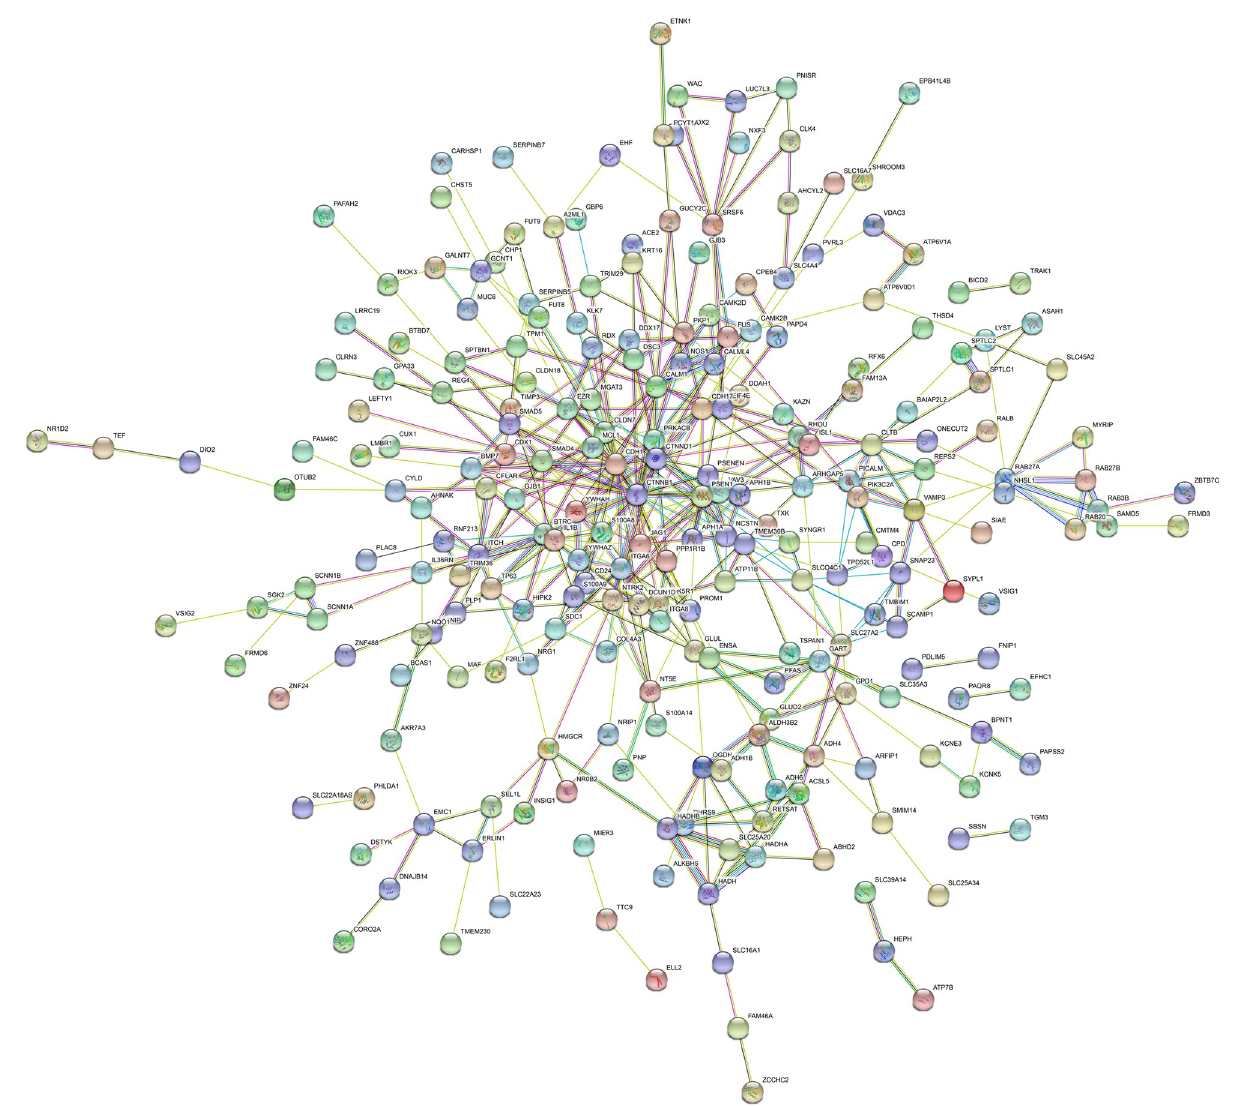
Fig 4. PPI networks of significantly downregulated